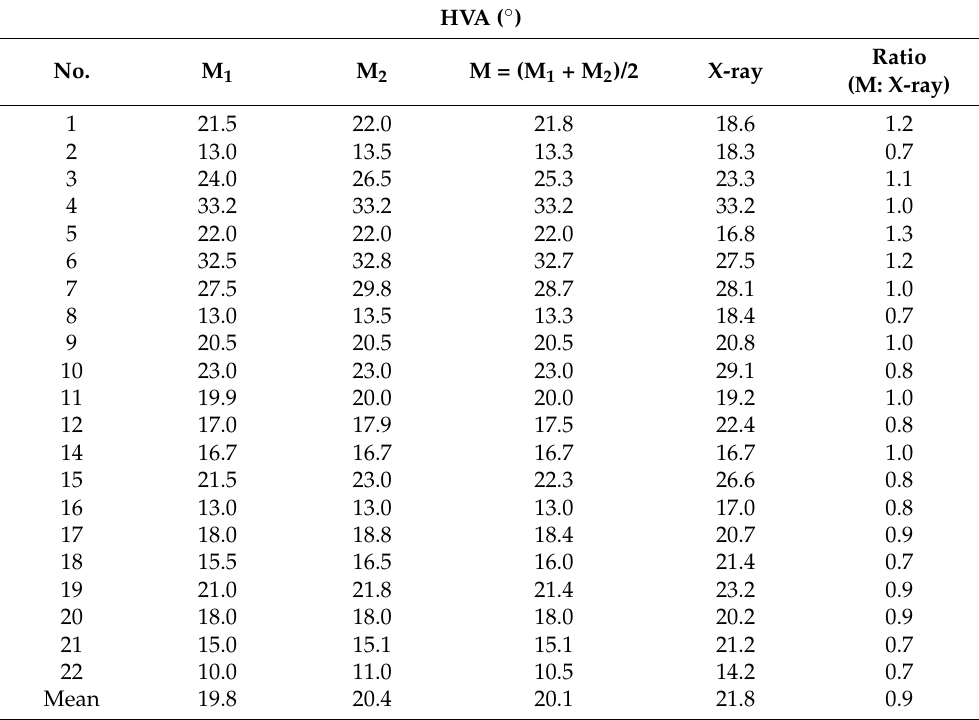
Table 2. Differences between X-ray and manual measurements of HVA ( n = 22).